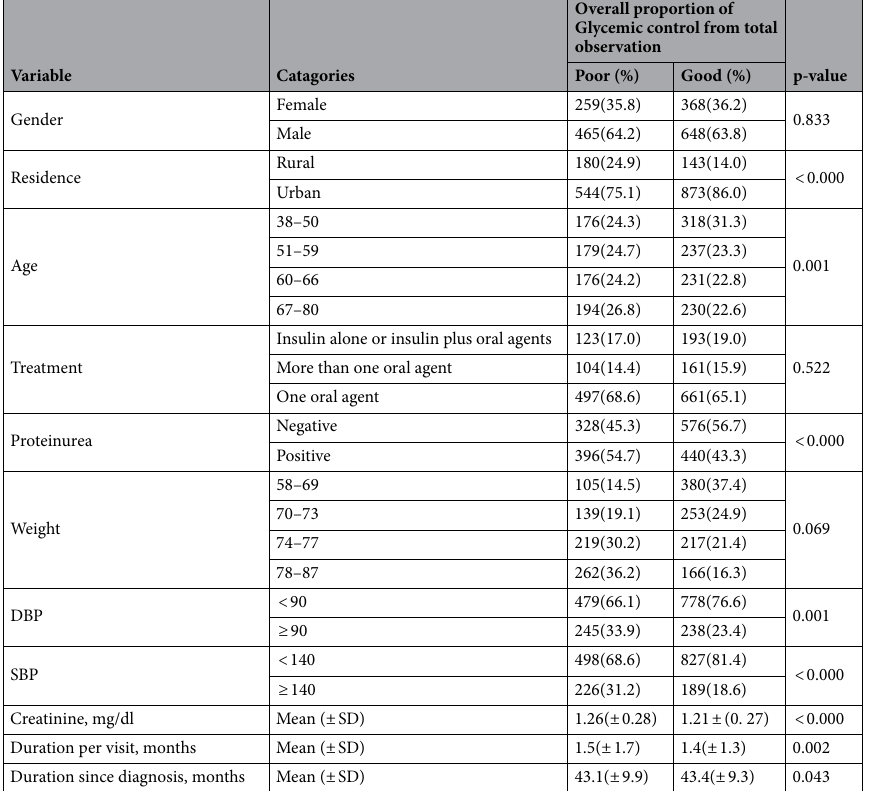
Table 2. Cross tabulation and Univariate analysis of glycemic control status for 191 patients with 1740 glycimic control status observations at DMRH and FHRH, December 2014–January